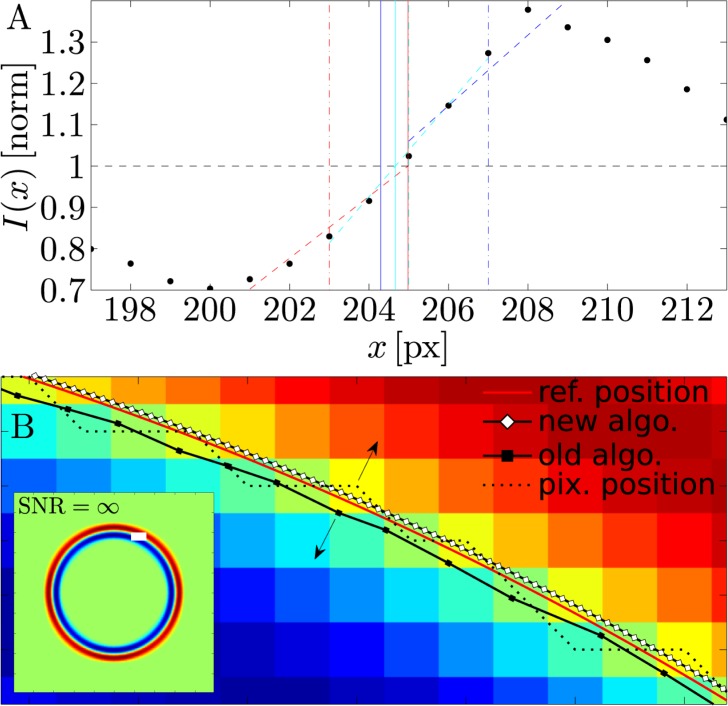
Image pixilation causes jitter in the positions obtained with the classical algorithm.(A) Illustration of how fitting at an offset from the gradient maximum affects the obtained fit-slope and results in a deviation in the final coordinate. (B) Comparison of the reference contour and the contour coordinates obtained from the previous method [13], and our refined algorithm here described. The artifact described in (A) leads to transverse shifts in the final position (black squares), whenever the pixel-position about which the fit is performed (dashed line) shifts transversely to the contour. The red line represents reference position of the circle used in the synthesis of the image with SNR = ∞, which is shown in the inset indicating the shown area with a white rectangle. The tracked coordinates obtained from the new algorithm (white diamonds) follow the reference position precisely.